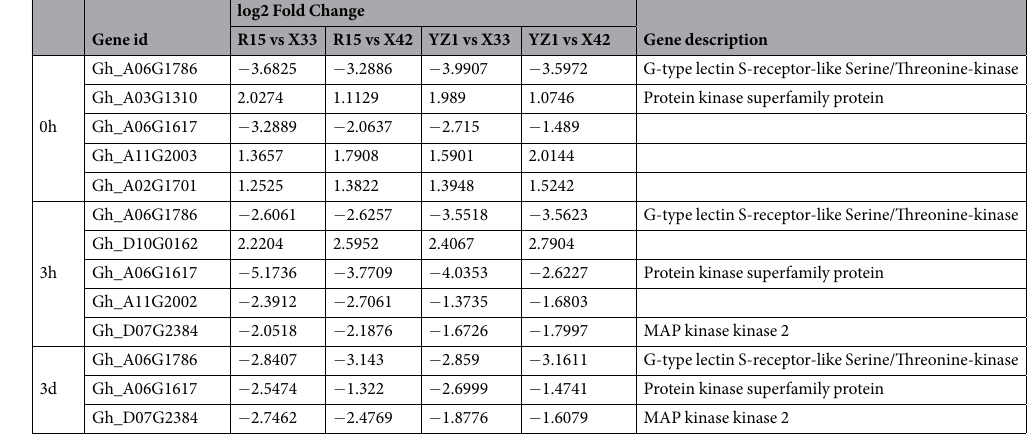
Table 2. Protein kinase-related genes differentially expressed in the